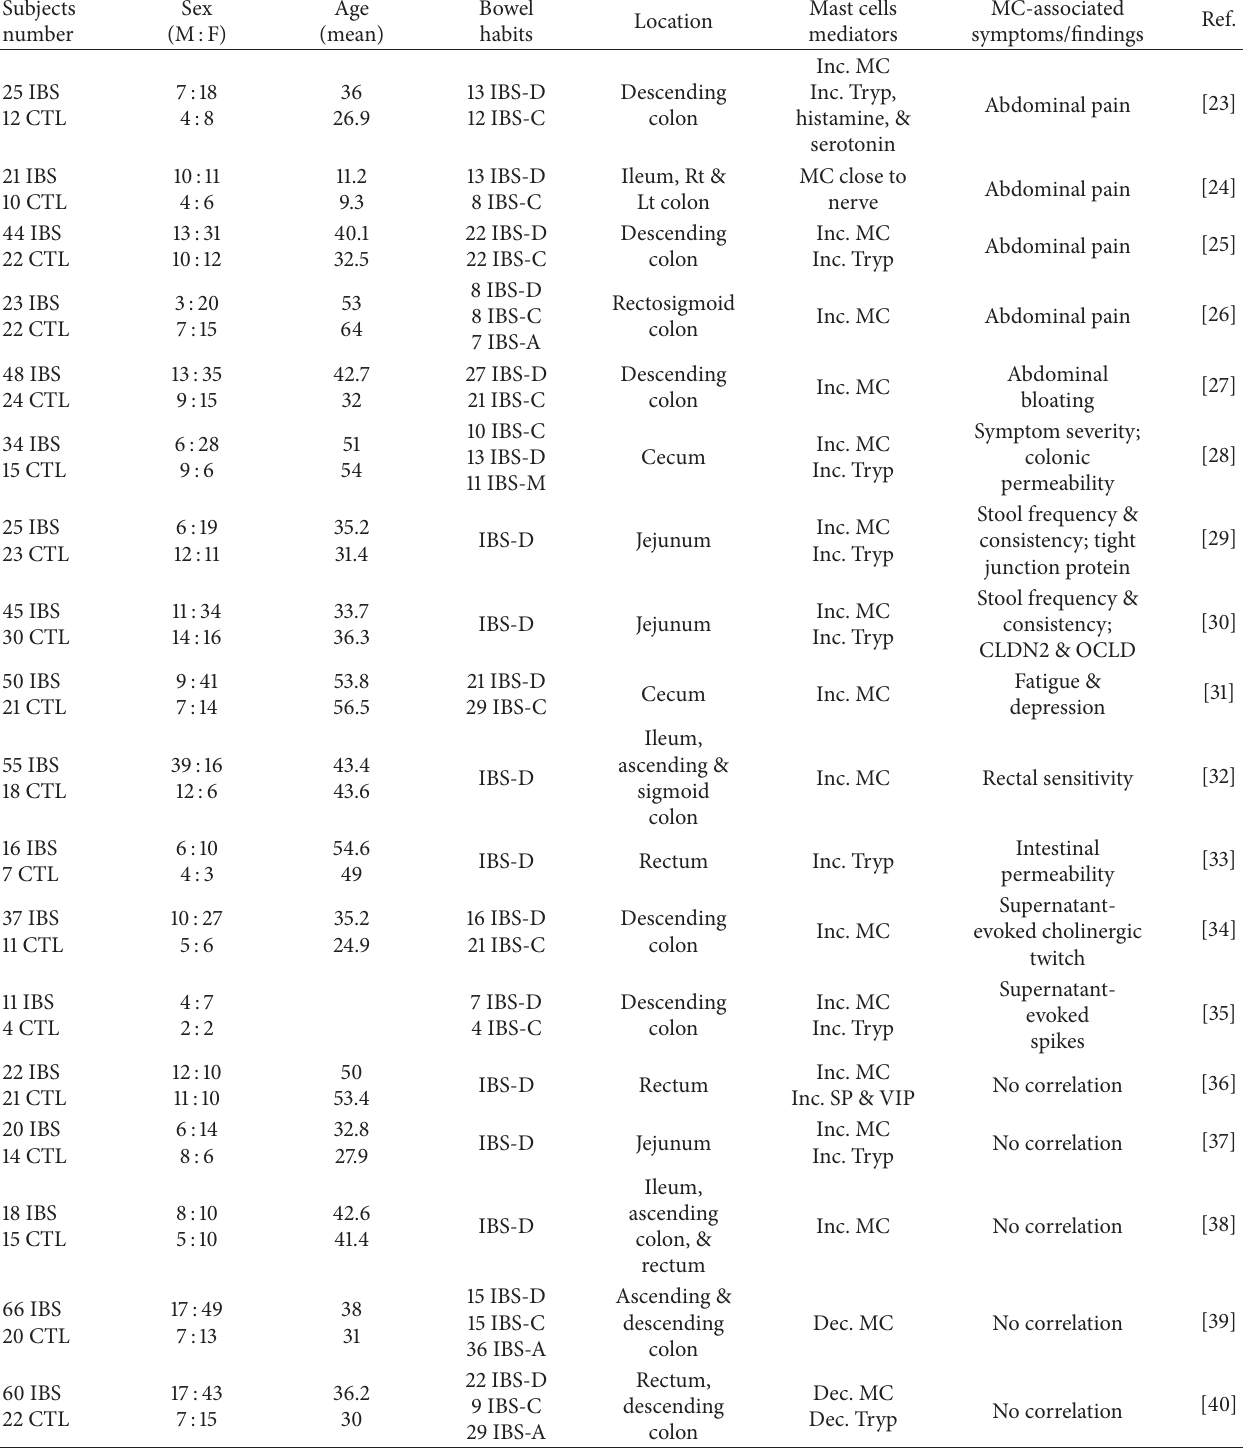
Table 1: Studies examining correlations between mast cells and symptoms in